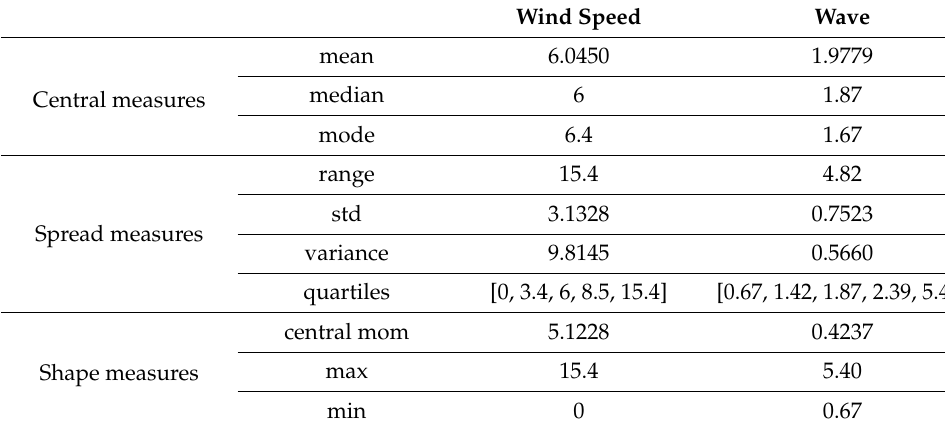
Figure 5. Histogram of wind speed ( left ) and wave height ( right ). Table 4. Statistical measures of wind and wave